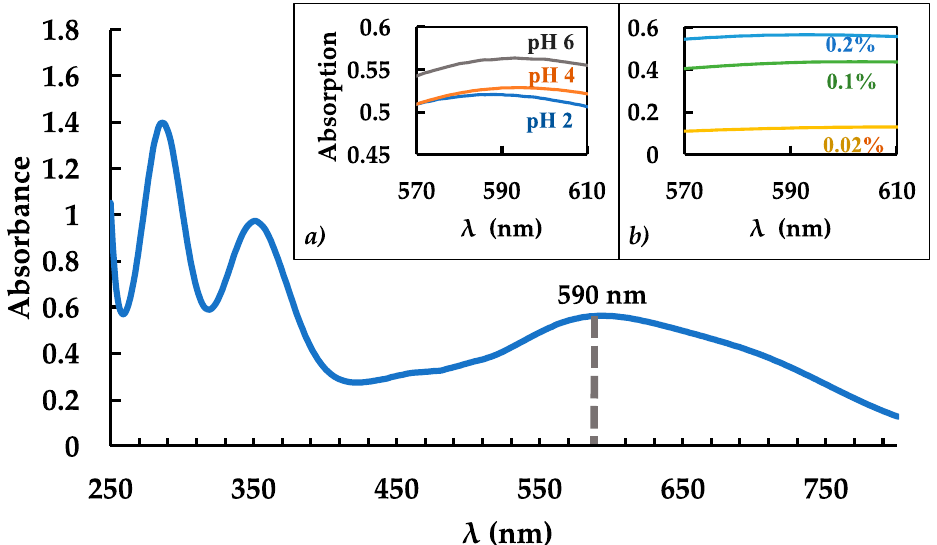
Figure 2. Absorption spectrum of calibration level 4 (50 µ g/mL) at pH 6 and iodine reagent (I 2 /KI) concentration of 0.2% (which was added to the starch sample (final volume 10 mL)) with a wavelength range of 250–800 nm. The peak absorption is noted at 590 nm. Panel a shows the pH dependance of starch, with 3 pH levels noted near the peak of 590 nm (50 µ g/mL). Panel b shows the iodine reagent concentration added to the starch solution, with 3 concentration levels near the peak of 590 nm (50 µ g/mL). Full spectra figures at different pH and iodine reagent concentrations are provided in the supplementary section (Figures S3 and S4).